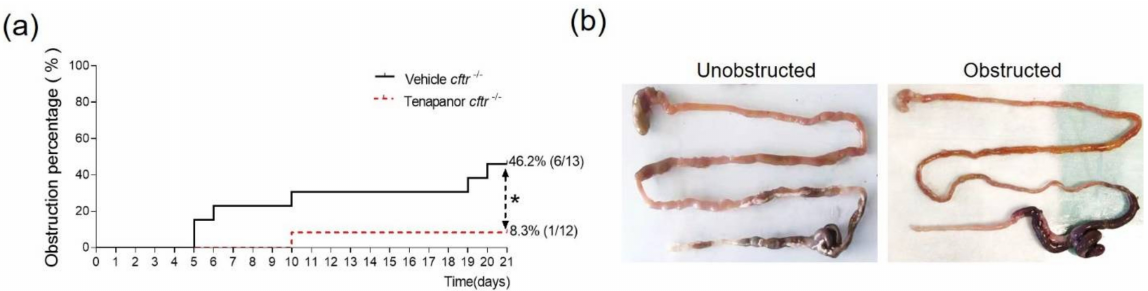
Figure 3. Significantly lower incidence of obstructions in tenapanor-treated cftr − / − mice. ( a ) Treat- ment with tenapanor resulted in a significant reduction in the incidence of intestinal obstructions in cftr − / − mice compared to the vehicle-treated cftr − / − mice. ( b ) A representative image of the obstruction between the ileum and proximal colon is shown. All mice but one were suspected to have suffered an obstruction while alive and were sacrificed prior to death. * p <